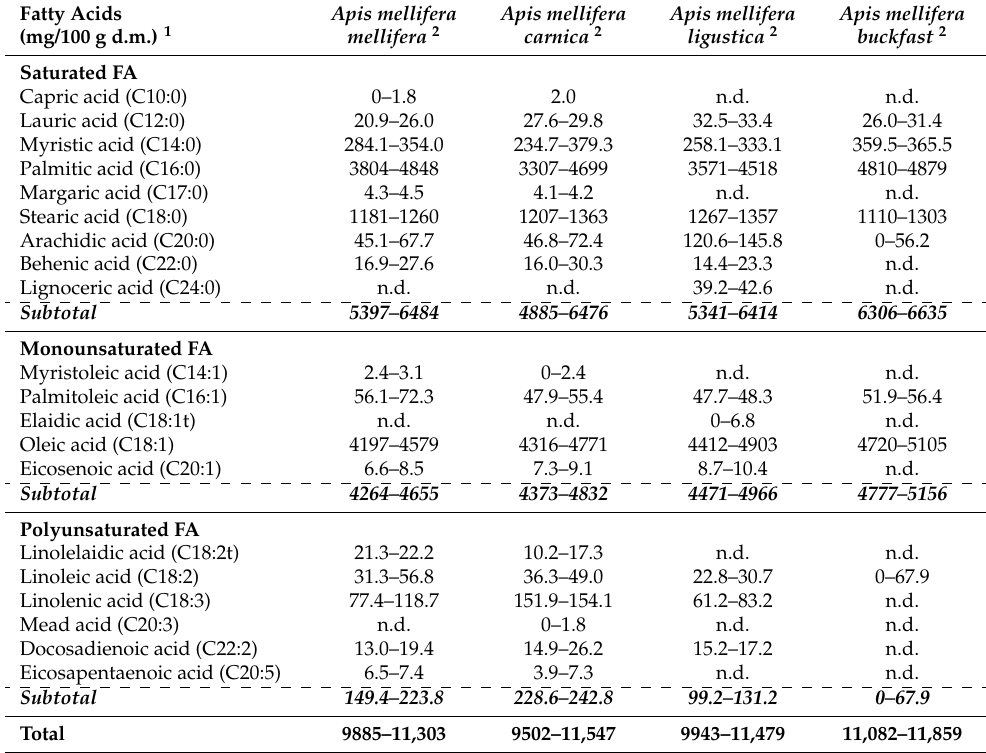
Table 5. Fatty acid profile of drone pupae of Apis mellifera subspecies [38]. Fatty Acids (mg/100 g d.m.)